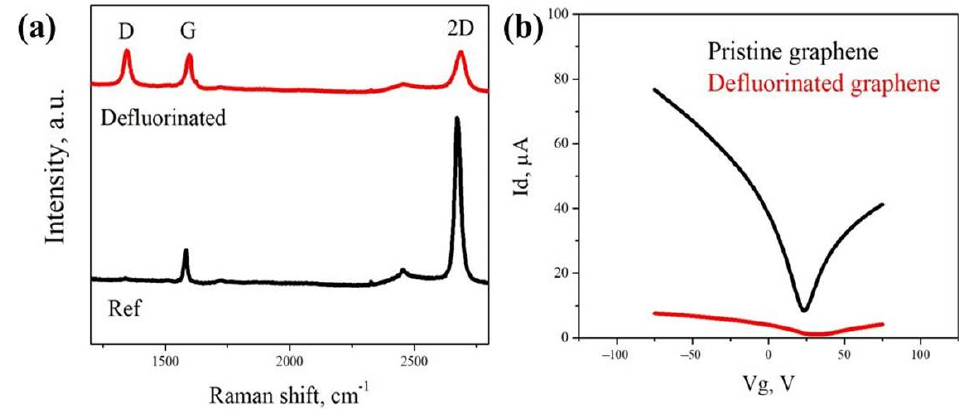
Figure 4. Characterizations of graphene after the fluorination/defluorination cycle: ( a ) shows the Raman spectra of initial pristine graphene and defluorinated graphene. The emerging D peak after defluorination suggests the introduction of disordering as a result of the electron beam irradiation; ( b ) shows the gated curves of pristine graphene (in black) and defluorinated graphene (in red).